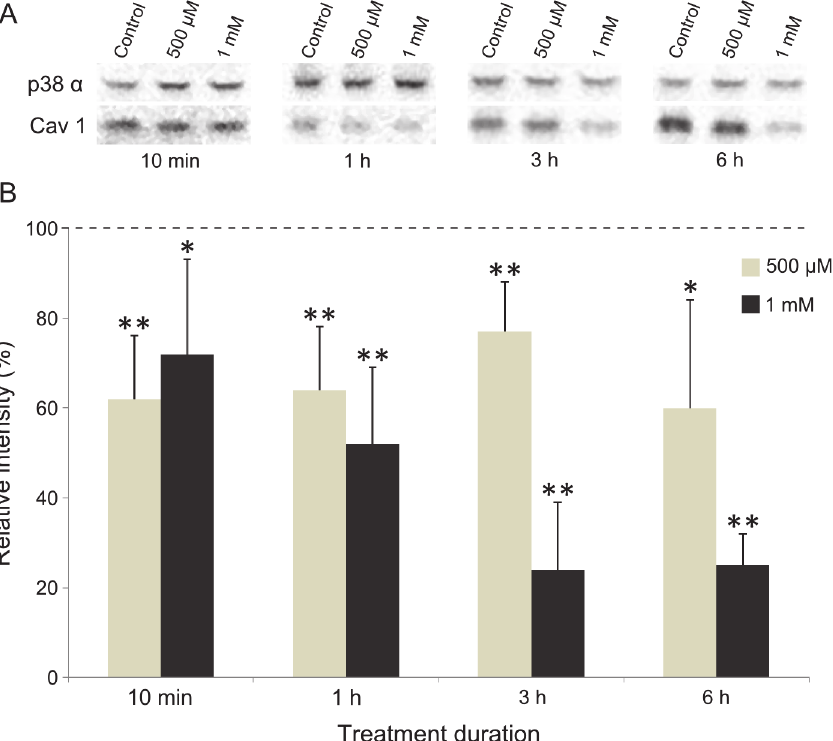
Fig 1. Effect of H 2 O 2 on caveolin 1 expression level. Cells were treated with 500 or 1000 μ M H 2 O 2 for different time. Proteins were extracted and 15 μ g was subjected to SDS-PAGE. Immunodetection was carried out using specific antibodies for caveolin 1 and p38 α , which was used as a loading control (A). The level of caveolin 1 (cav1) was quantified and expressed as a percentage of the level obtained in the untreated control cells ( — ). Bars on the graph represent the SEM (B). * Significantly different from the control ( P < 0.05), ** significantly different from the control ( P < 0.01). doi:10.1371/journal.pone.0122654.g001 Reactive oxygen species (ROS) were measured with the cell-permeant fluorogenic dye 2 ’ , 7 ’ - dichlorofluorescein diacetate (DCFDA). After cells were incubated with 500 or 1000 μ M H intracellular ROS content increased 4 or 6 times, respectively, as compared with the untreated controls (Table 2). The reactive oxygen species accumulated as soon as 10 min after H O , an increase of ROS intracellular level was observed, with- tion. After 1 h incubation with H 2 2 out being statistically different from 10 min (data not shown). In the meantime one of the multiple consequences of intracellular ROS accumulation was evaluated by the quantification of the carbonyl content, an indicator of protein oxidation [30]. As shown in Table 2 the amount of carbonyl groups was 0.98 nmol/mg of protein in control